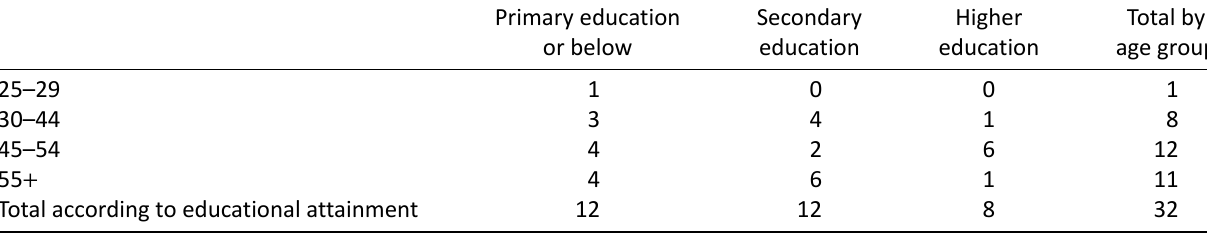
Table 1. Distribution of the sample by age group and educational